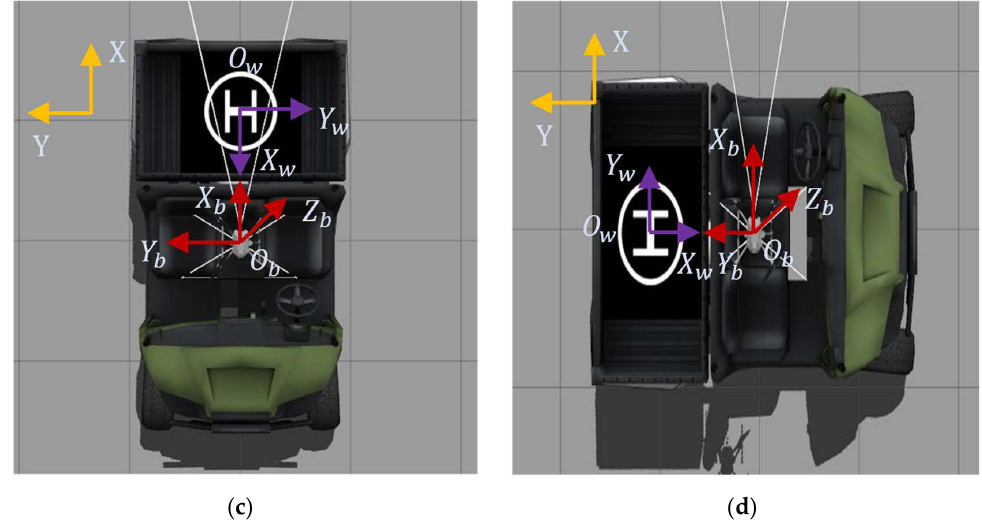
Figure 11. Stationary target with different yaw angles. ( a ) Yaw = 0°. ( b ) Yaw = 90°. ( c ) Yaw = 180°. ( d ) Yaw = 270°.